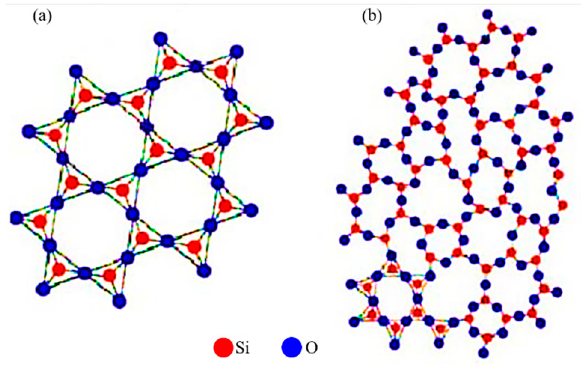
Figure 1. ( a ) Quartz SiO 2 and its ( b ) amorphous crystal structure [2].